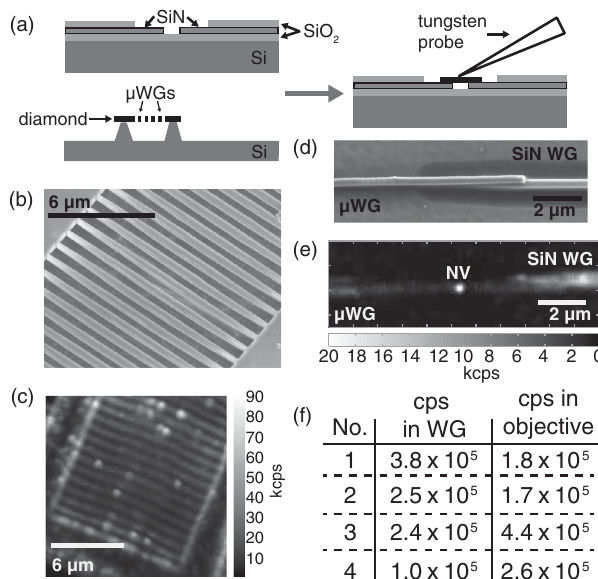
FIG. 2. (a) Illustration of integration of a diamond quantum node into a SiN PIC. Top left: A cross-section view of the coupling region of a SiN PIC before integration of the diamond. Bottom left: An array of diamond μ WGs resting on an etched Si chip. Right: The integration of a diamond μ WG onto a coupling region of the SiN PIC. (b) SEM and (c) confocal PL raster scan of a diamond μ WG array. (d) SEM and (e) confocal PL raster scan of FIG. 1. (a) Sketch of a SiN PIC with multiple quantum nodes. a diamond μ WG placed over a gap in a SiN WG, showing both (b) Simulation of the collection efficiency of NV fluorescence the gap and the waveguide used to collect the signal. The confocal into the diamond μ WG (dashed line) and into the SiN scan shows the bright NV center in the diamond μ WG. (f) NV single-mode waveguide with optimal parameters (solid line). photons collected into the waveguide and objective for four (c) FDTD simulation ( E field) showing the mode transfer x μ WGs integrated into consecutive SiN WGs at 100 μ W of from a single-mode diamond waveguide into a single-mode excitation. SiN